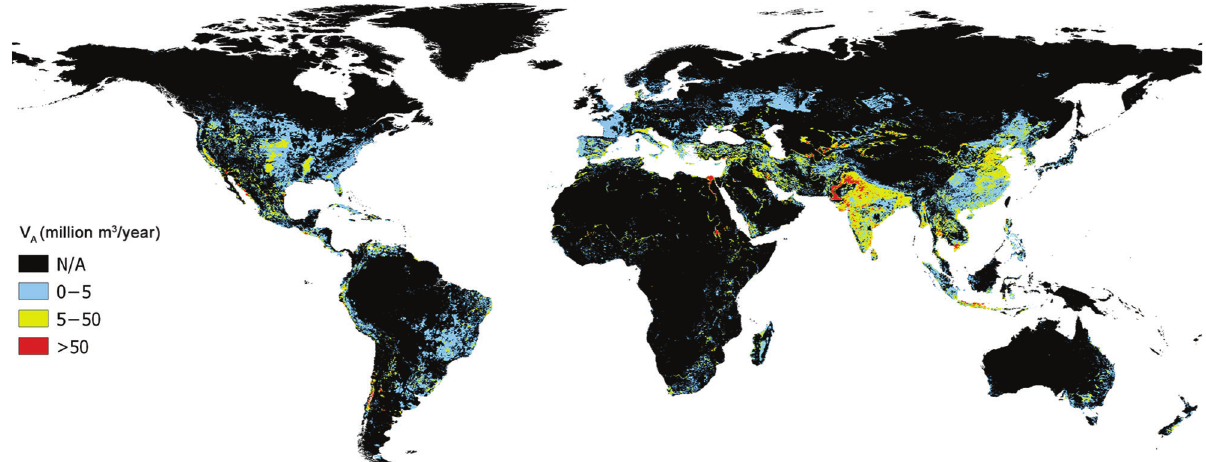
Agriculture freshwater withdrawal for ) in million m 3 . the year 2018 ( V A 2018 Geographic projection. Resolution 5 arc-minutes (approximately 10 km at the